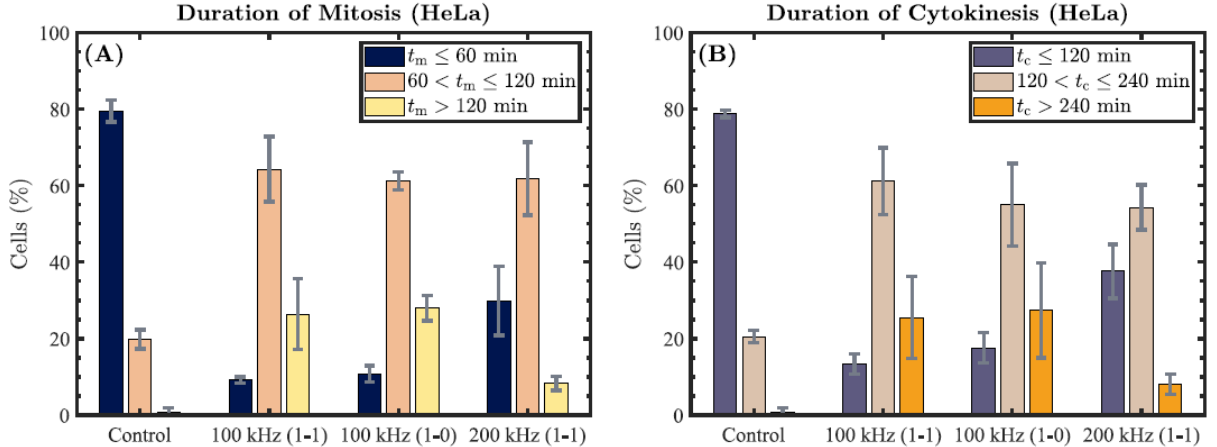
Figure 7. The HeLa cells from each set of experiments were grouped based on the length of mitosis ( t m ≤ 60 min, 60 < t m ≤ 120 min, or t m > 120 min) and the length of cytokinesis ( t c ≤ 120 min, 120 < t c ≤ 240 min, or t c > 240 min). Graphs represent the percentage of the cells in each category, reported as the mean ± SD from three independent experiments. ( A ) Results obtained by grouping the control and TTFields-exposed HeLa cells by their duration of mitosis. ( B ) Results obtained by grouping the control and TTFields-exposed HeLa cells by their duration of cytokinesis.